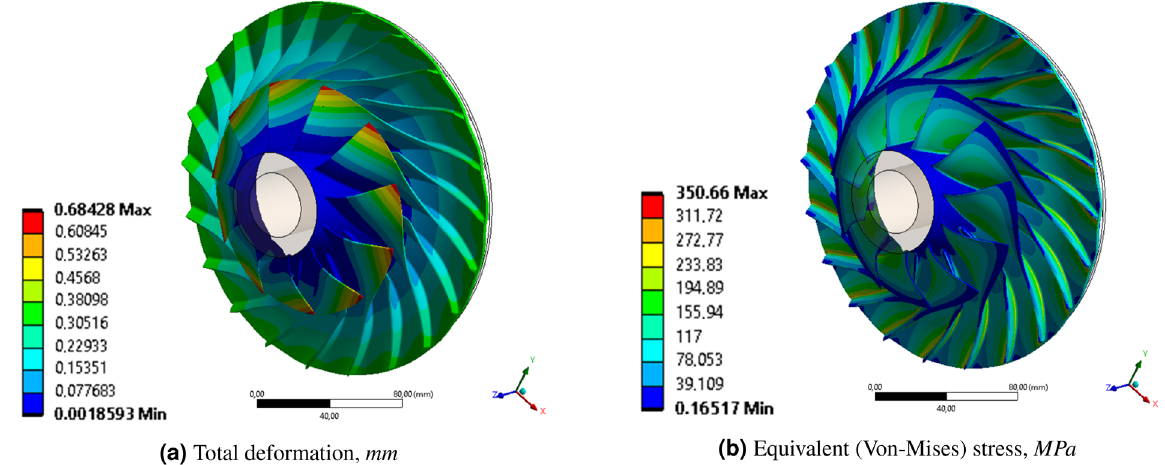
Figure 5. Distribution of ( a ) total deformation and ( b ) equivalent (von Mises) stress of the centrifugal compressor (analysis No. 6) (Ansys Mechanical 34